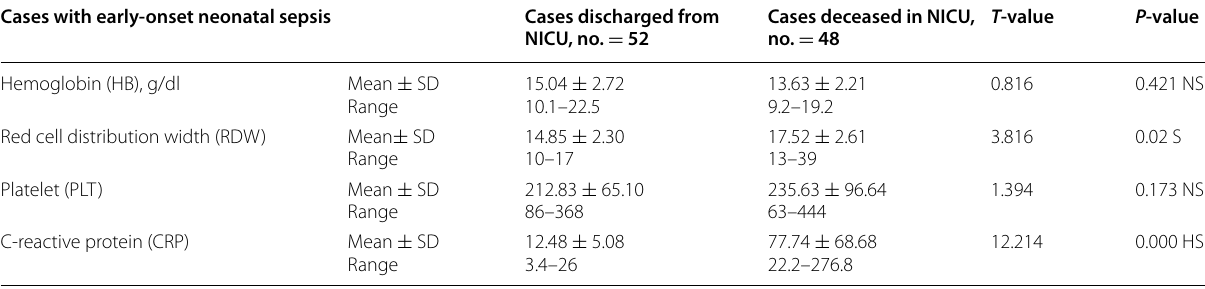
NS not significant, S significant, HS highly significant